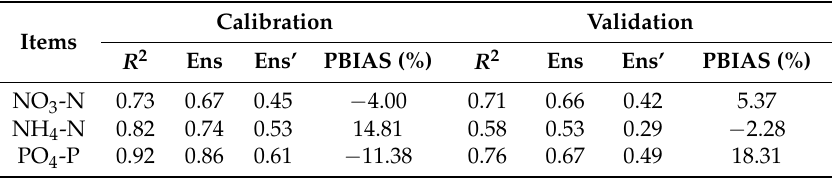
Table 3. Statistical parameters of model performance for nutrient